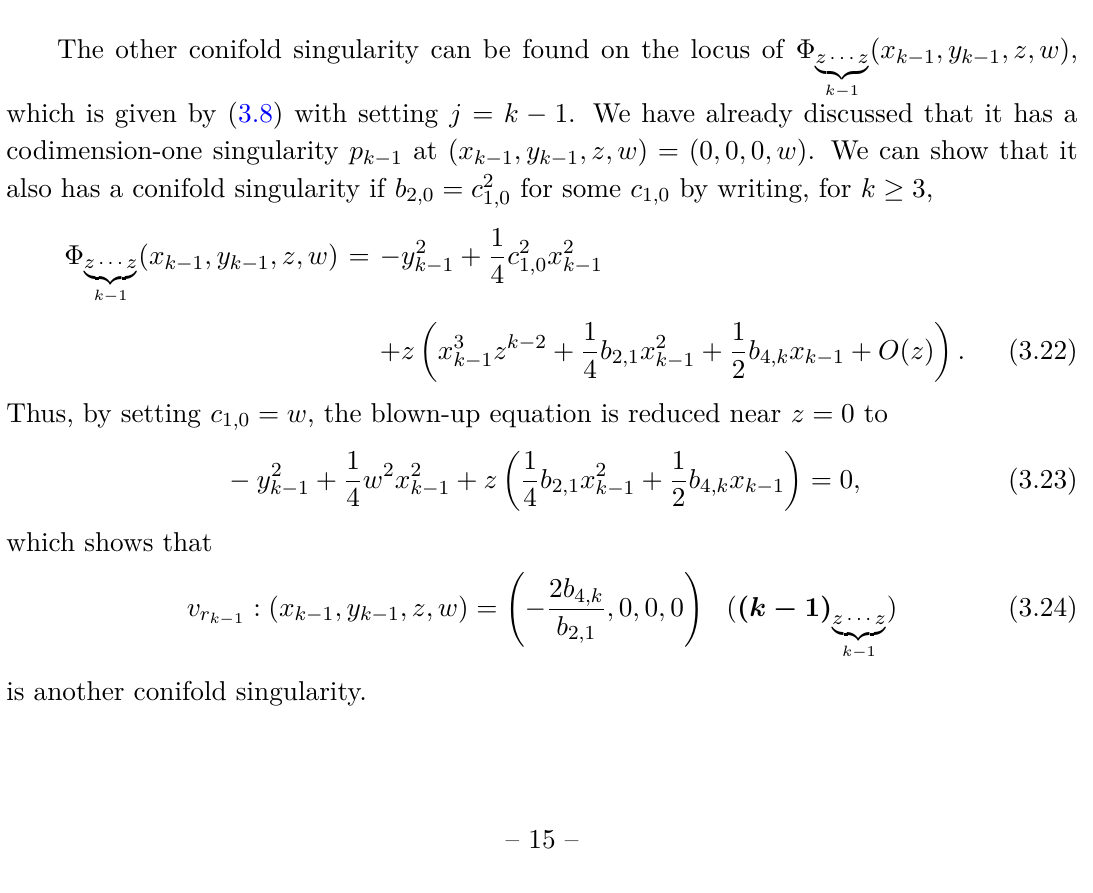
Figure 1 . Singularities and exceptional curves arising in the blow-up of a split I 2 k model near a D 2 k point w = 0 . “Codimension-one” singularities and conifold singularities are depicted with red and yellow x’s, respectively. Each bold horizontal arrow indicates a blow-up at a “codimension- one” singularity, and the final thick downward arrow means small resolutions of all the conifold singularities. The thin downward arrows denote the w → 0 limit. The left-most vertical line in each figure represents the original singular